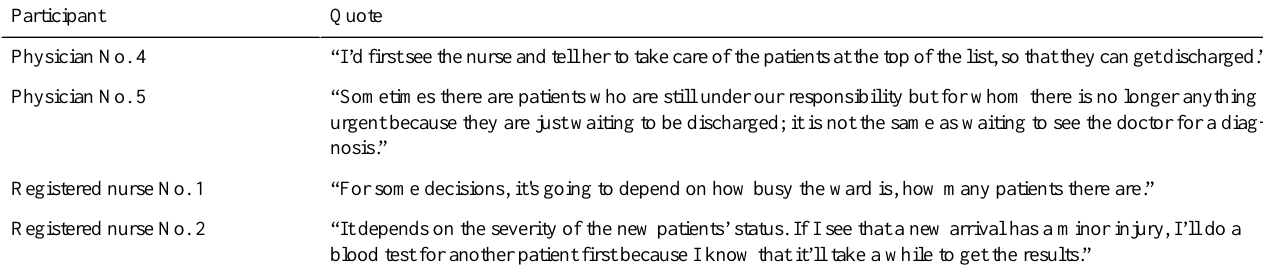
Table 2. Quotes from registered nurses and physicians during phase 2 of the user testing.